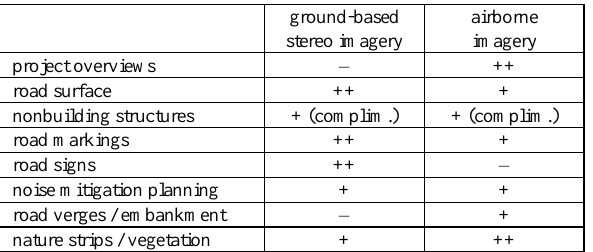
Table 2. Suitability of ground-based and airborne stereo imagery for road infrastructure